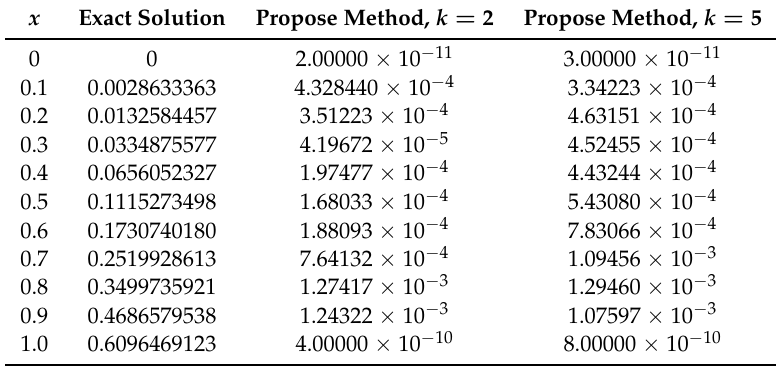
Table 2. Absolute errors for the proposed method with k = 2,5 for Example